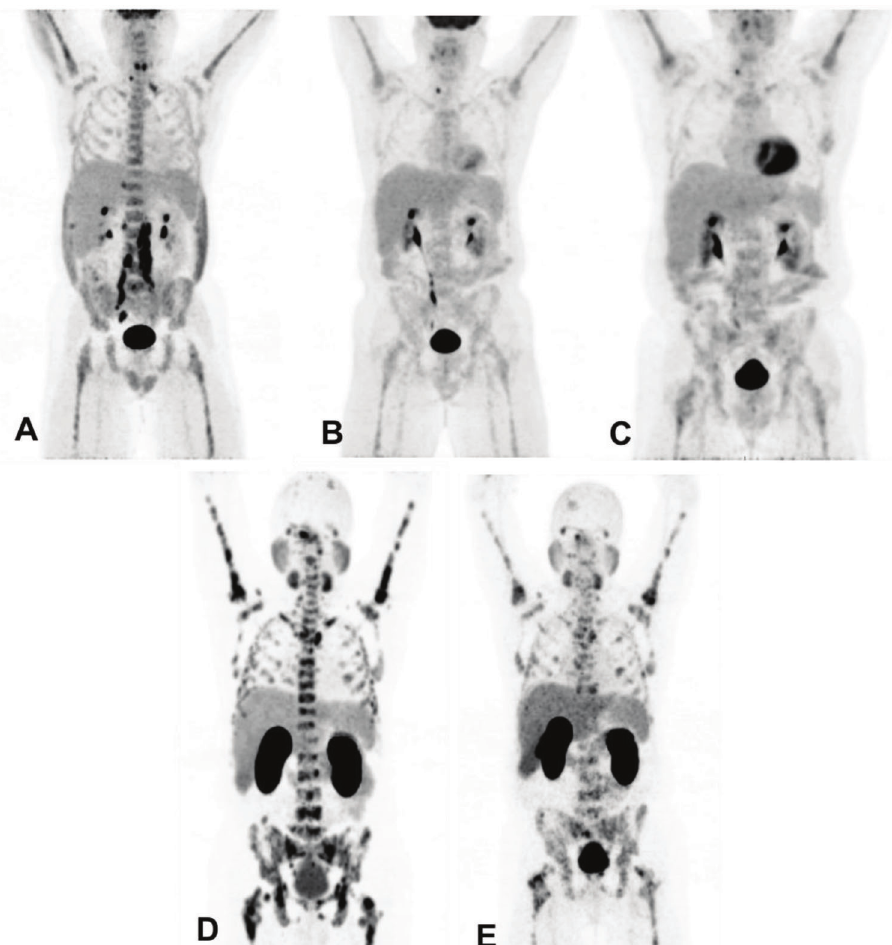
Figure 3 - Example of different biological behaviors of PCa with treatment assessed by different tracers: (A) FDG PET in patient with advanced PCa showing retroperitoneal nodal and diffuse bone disease; (B) After beginning ADT, FDG PETshows a marked reduction in FDG uptake in the lesions; (C) PCa has become resistant to castration. Note subtle increase in diffuse FDG uptake in the skeleton. (D) At the same timepoint as C, PSMA PET was performed, showing marked bone disease, leading to an improved assessment of disease extension; and (E) PSMA PET performed 4 months after chemotherapy shows partial reduction in PSMA expression of diffuse skeletal